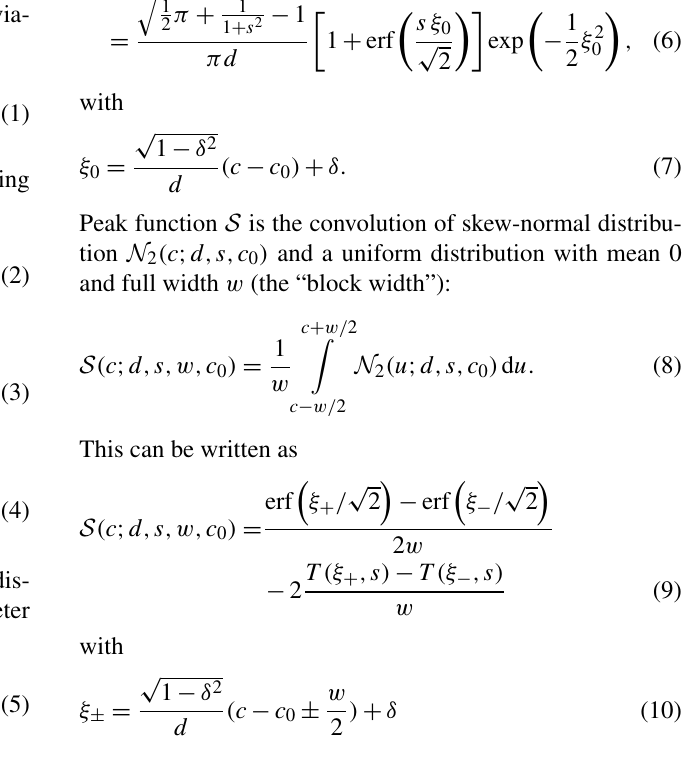
The normal distribution with mean 0 and standard